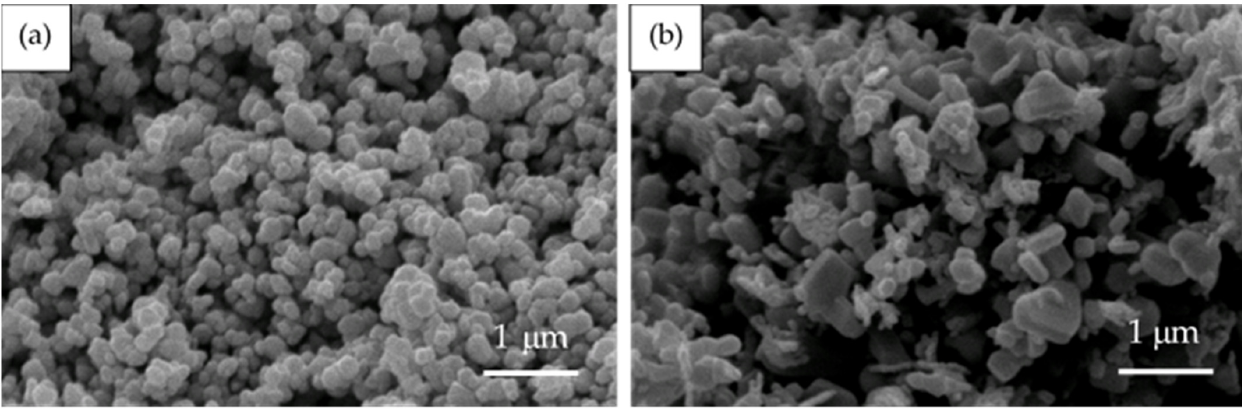
Figure 2. XRD patterns of ( a ) TiO and ( b ) ZnO.